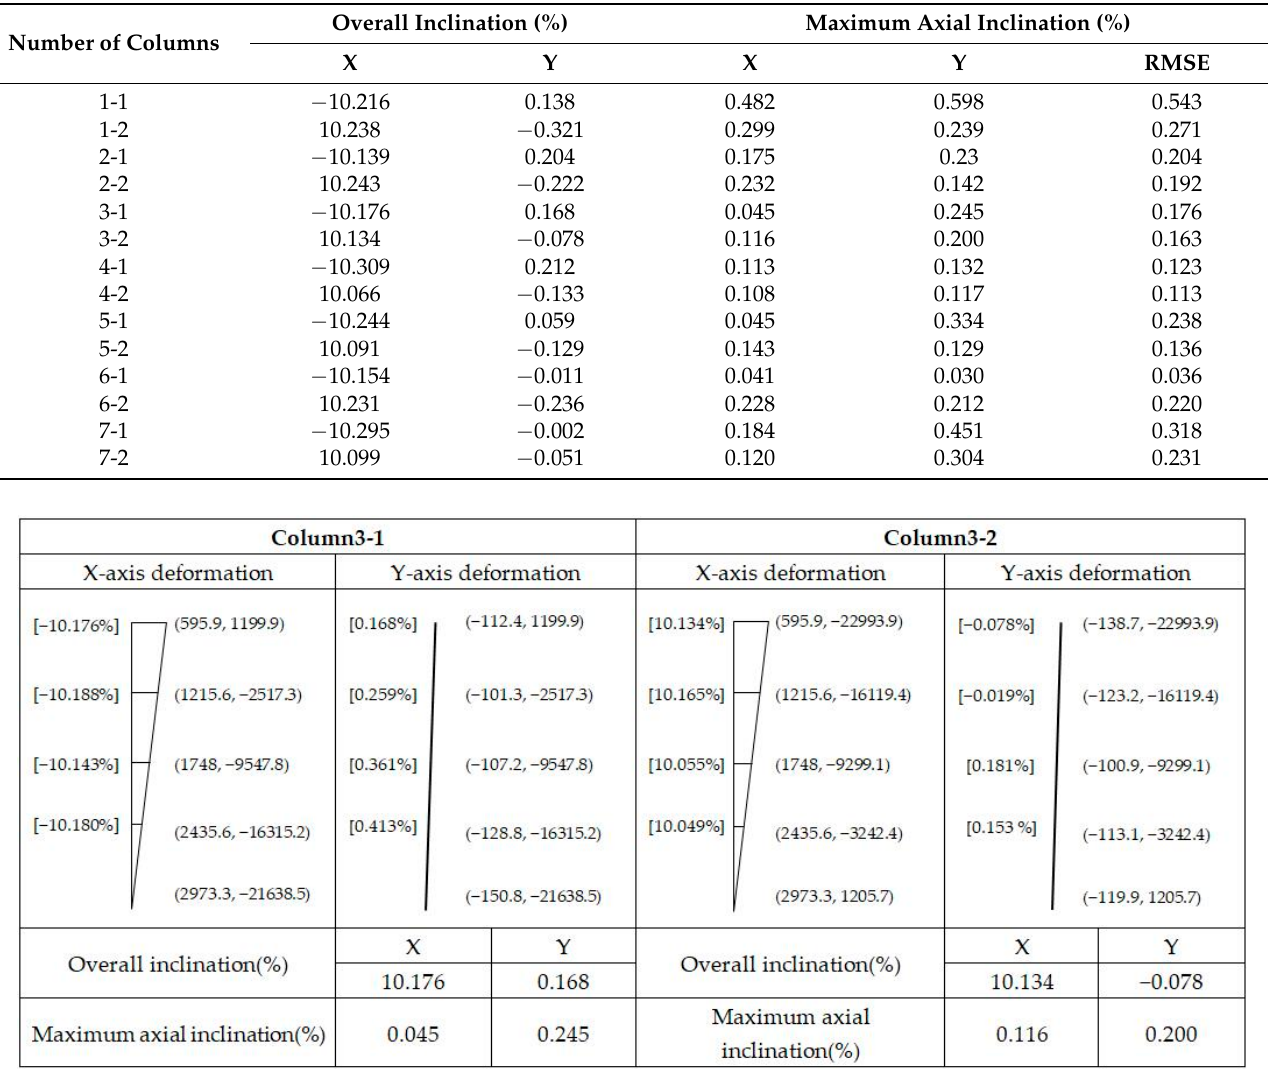
Table 3. Inclination of each column by the proposed method.